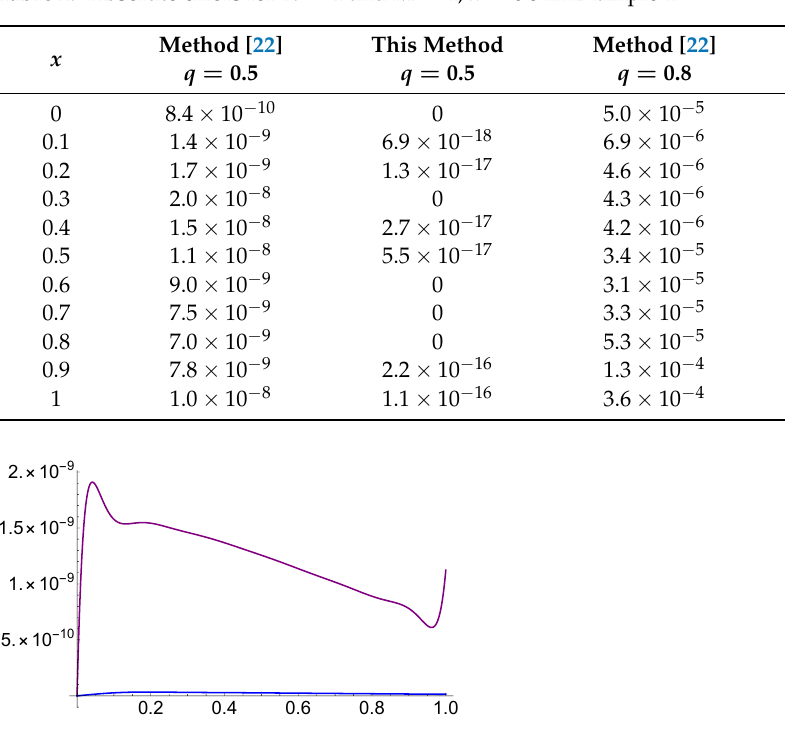
Figure 5. The absolute errors for f ( x ) for α = 1 (purple) and α = 2 (blue), for Example 4.